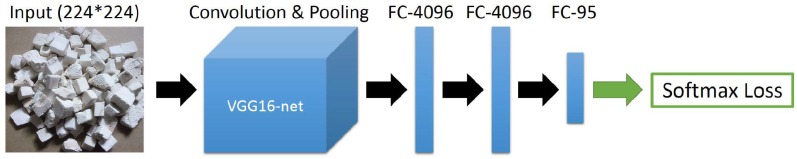
An illustration of training the recognition CNN model based on the VGG16 model pre-trained on ImageNet 2012 dataset.